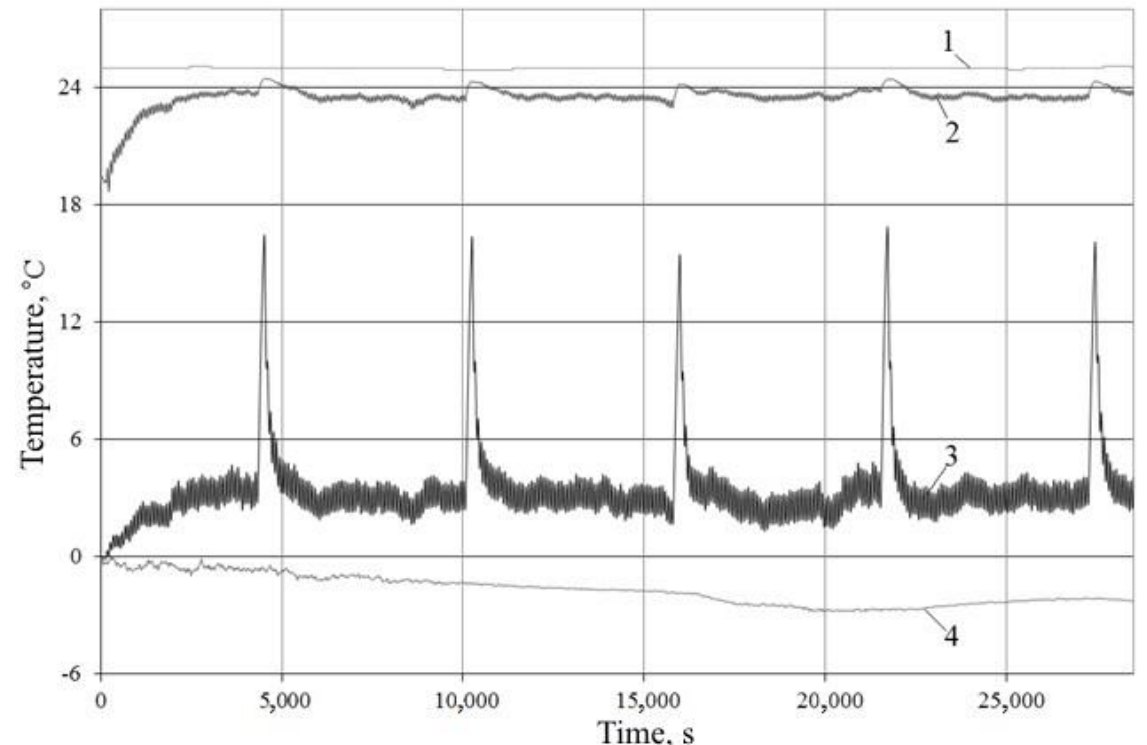
Figure 6. Experiment results example with extended intervals (τ ≈ 8 h): 1— T in , 2— T a1 , 3— T a2 , 4— T out .